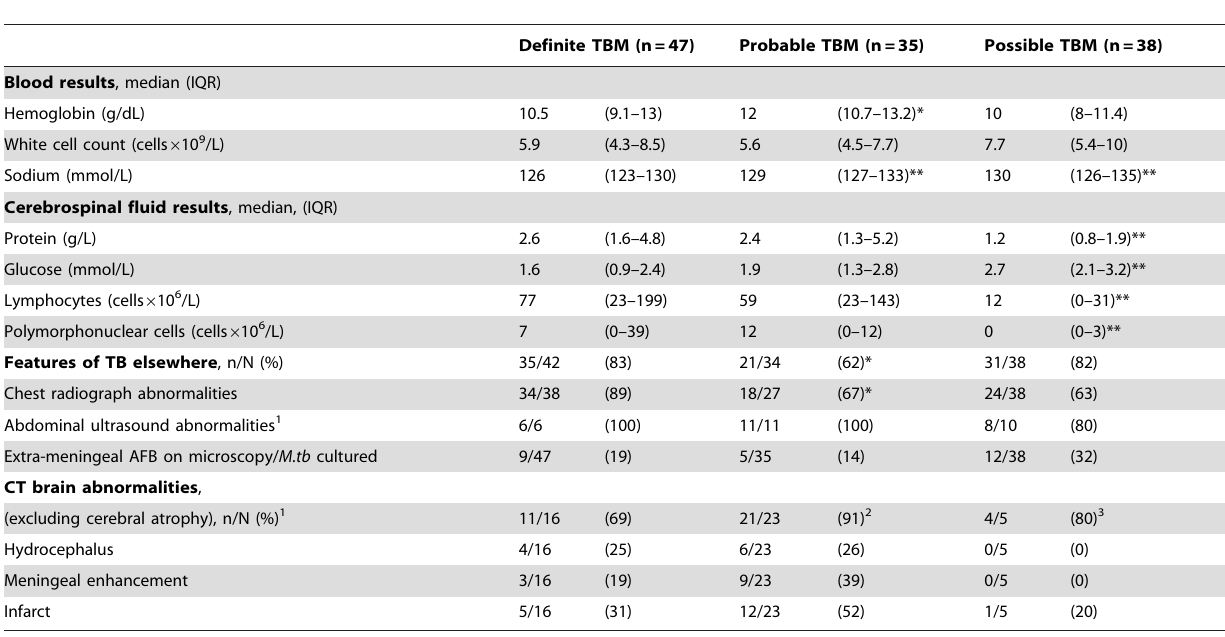
Table 2. Laboratory and radiological investigation findings of patients with definite, probable and possible tuberculous meningitis